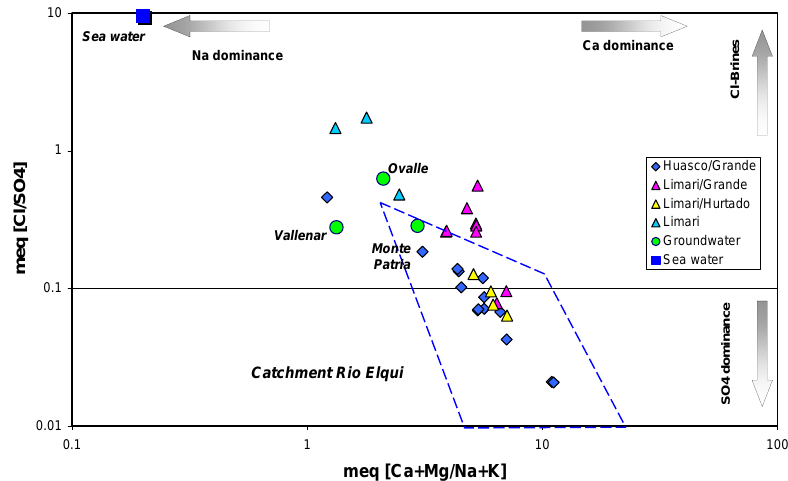
Fig. 2. Hydrochemical characteristics of river and groundwater from the Rio Huasco and Rio Limar ´ ı catchments in relation to the Rio Elqui catchment (dotted